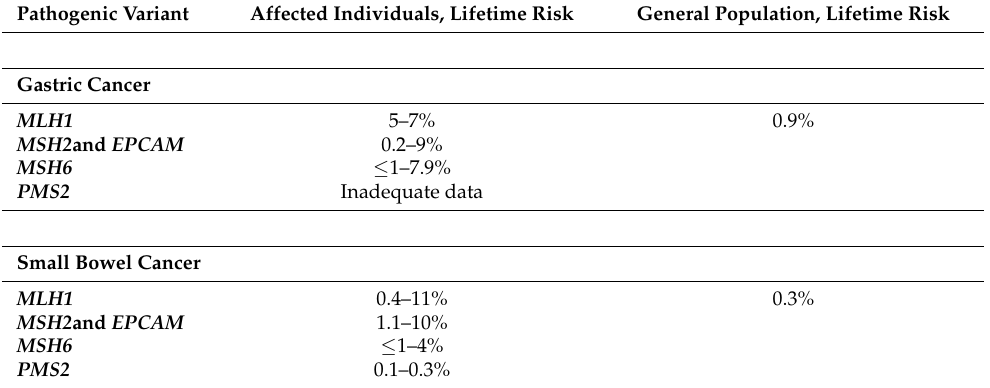
Table 2. Lifetime risk of gastric and small bowel cancers in Lynch syndrome by pathogenic variant